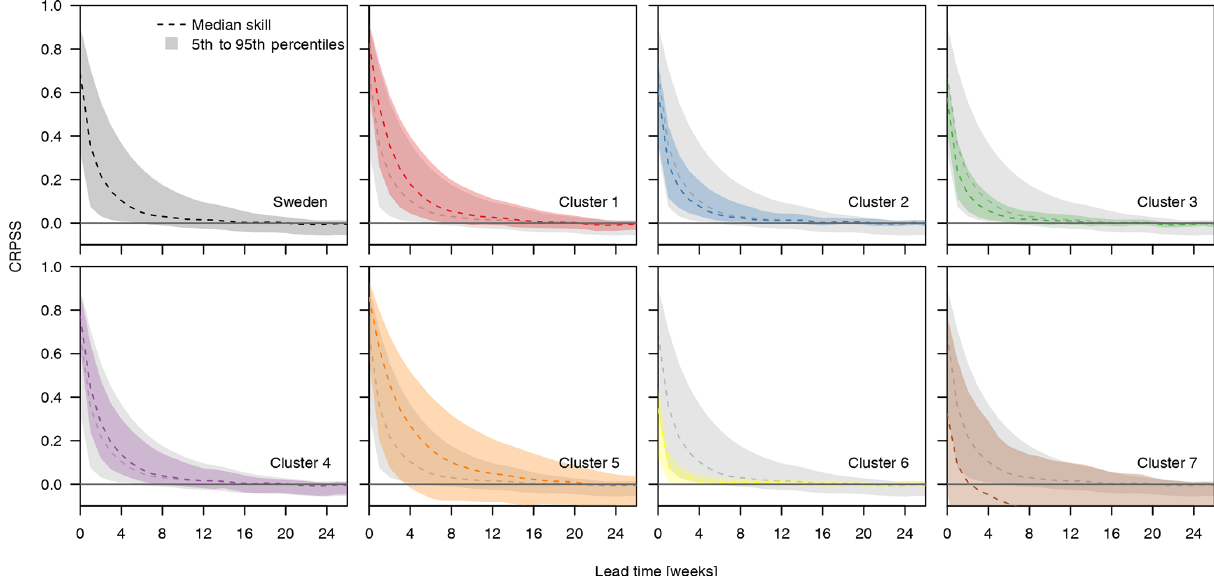
Figure 8. Streamflow forecast skill (in terms of CRPSS) as a function of lead time for the entire country (top-left corner; also shown in Fig. 3a) and each of the seven clusters. The median skill and range for Sweden are provided in the background of clusters 1–7 to provide a reference for the values of each